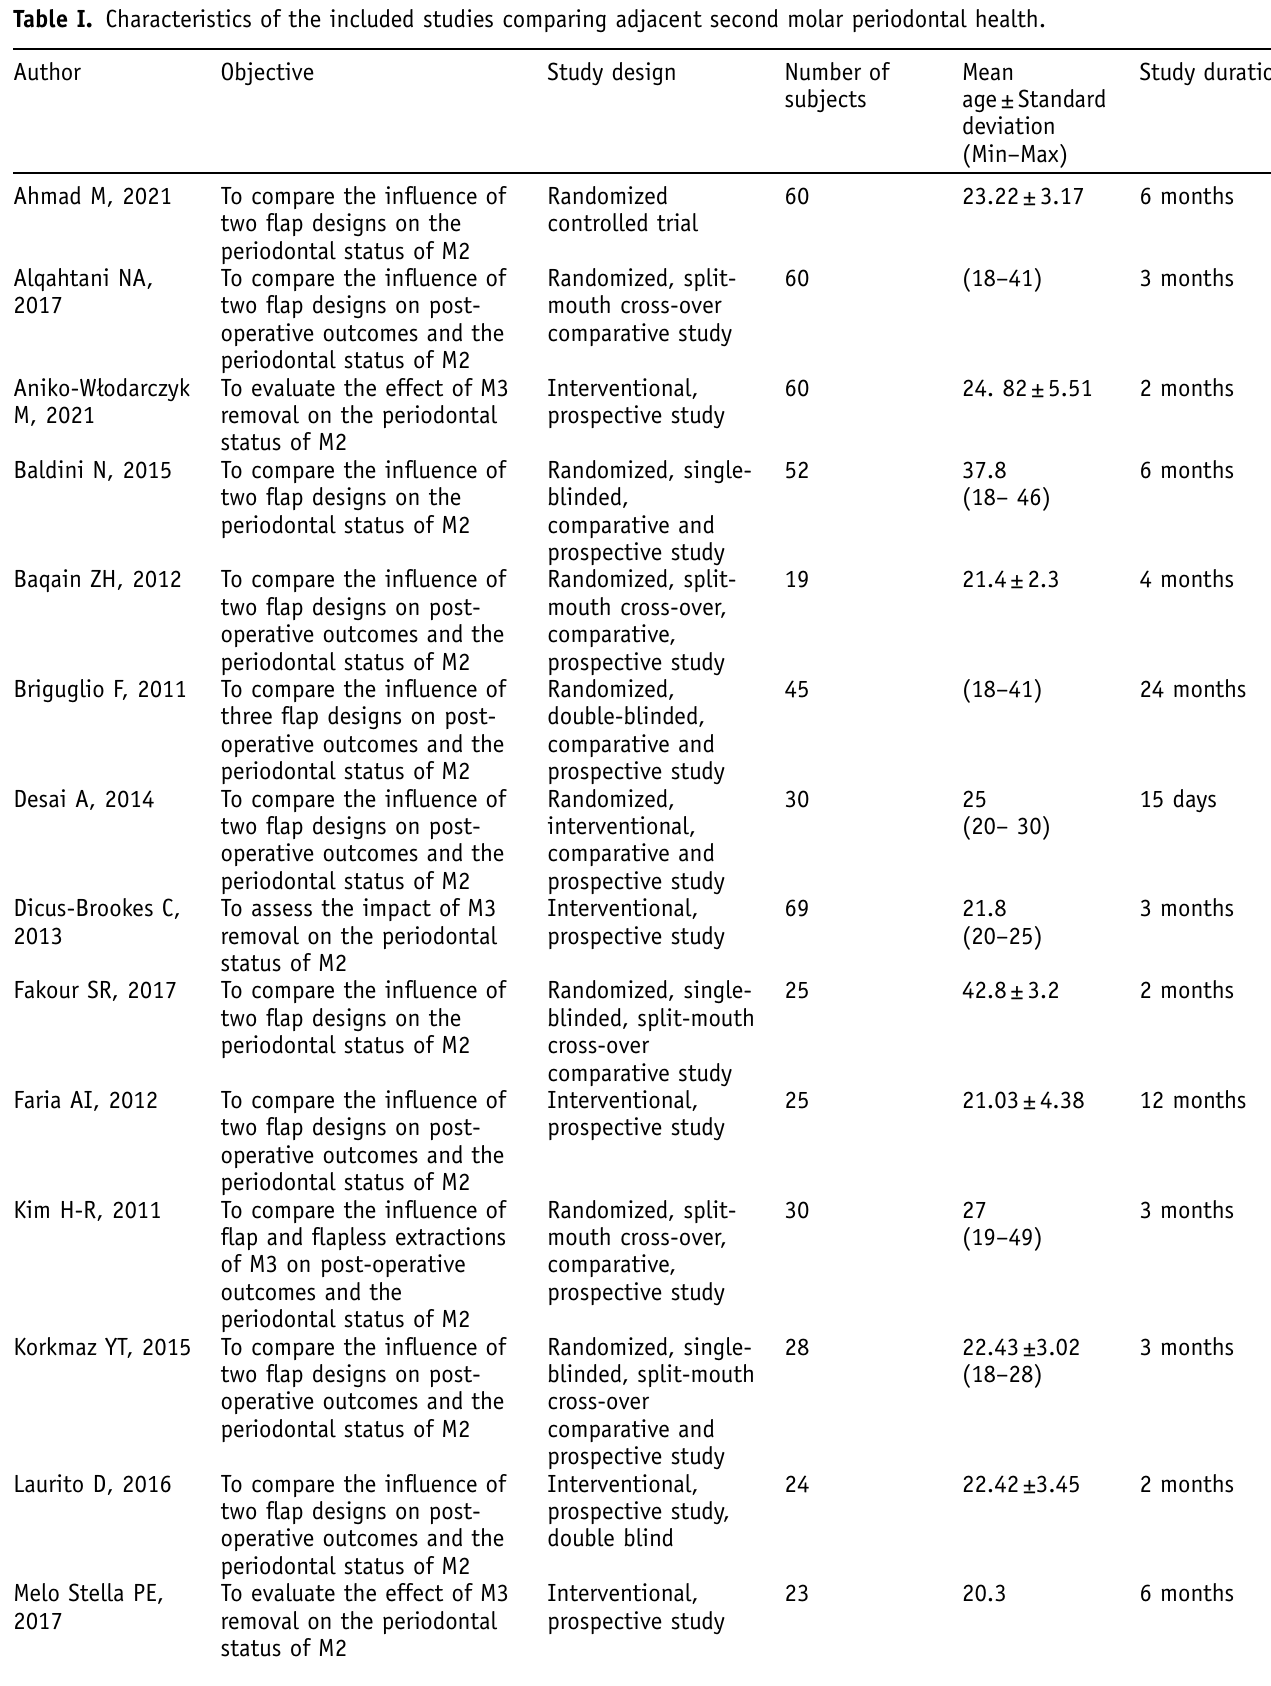
Table I. Characteristics of the included studies comparing adjacent second molar periodontal